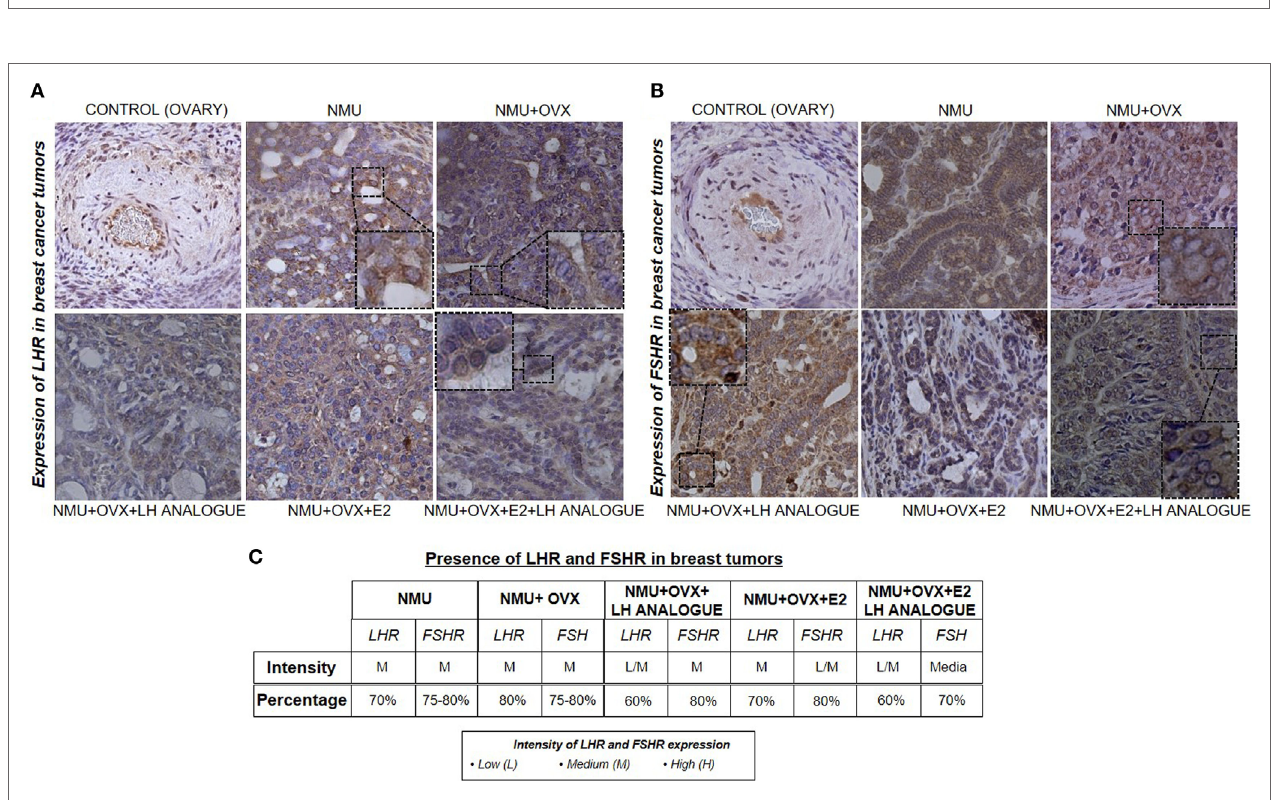
FigUre 5 | Regulation of E2 and LH in mammary tumors induced by N-nitroso-N-methylurea. (a) Reports a visual synthesis of the different treatment schedules in female rats. (B) Average tumors per rat, tumor number, and tumor size ( Δ T1 = T 30 /T 0 and Δ T2 = T 60 /T 0 ) after 31 weeks of treatment in rats injected with NMU. (c) Tumor size vs. Δ T ( Δ T = 60 days) was measured for each tumor. (D–g) Plasma levels (mean + SD) of E2 (nmol/l), LH (pmol/l), and follicle-stimulating hormone (FSH) (pmol/l) in fertile-control, NMU, NMU + OVX, NMU + OVX + LH analog, NMU + OVX + E2, or NMU + OVX + LH + E2 analog female rats. The statistical differences between mean values were determined by one-way analysis of variance (ANOVA), followed by Tukey–Kramer Multiple-Comparisons test. Values of * P < 0.05 indicate significant differences between NMU (a–c) and Control (D–g)